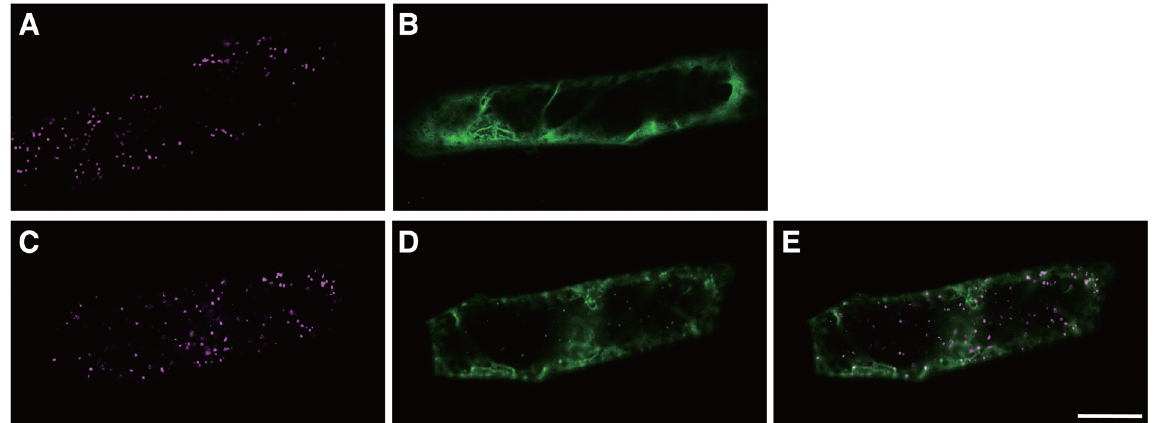
Fig 5. Detection of multiple protein — protein interactions using transient expression assays. (A, B) Two types of vectors were introduced as controls. Representative images of interactions of nRFP-PEX7 with PTS2-cRFP (A) and AtSEC31A-nYFP with AtSEC13A-cYFP (B). (C-E) Four types of vectors, nRFP-PEX7, PTS2-cRFP, AtSEC31A-nYFP, and AtSEC13A-cYFP, were introduced simultaneously into onion epidermal cells. Representative images of interactions of nRFP-PEX7 with PTS2-cRFP (C) and AtSEC31A-nYFP with AtSEC13A-cYFP (D) in the same cell. (E) Merged image of (C) with (D). Bar: 50 μ m.